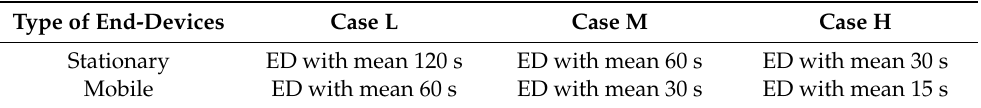
Table 6. Message generation